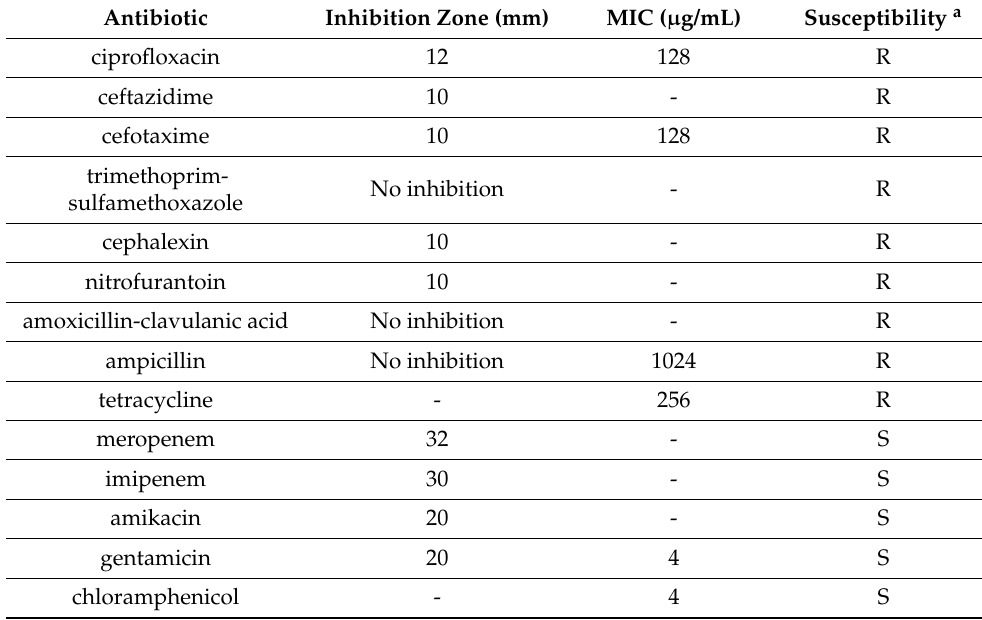
Table 1. Antimicrobial susceptibility testing of selected antimicrobial agents used against 9KP strain.